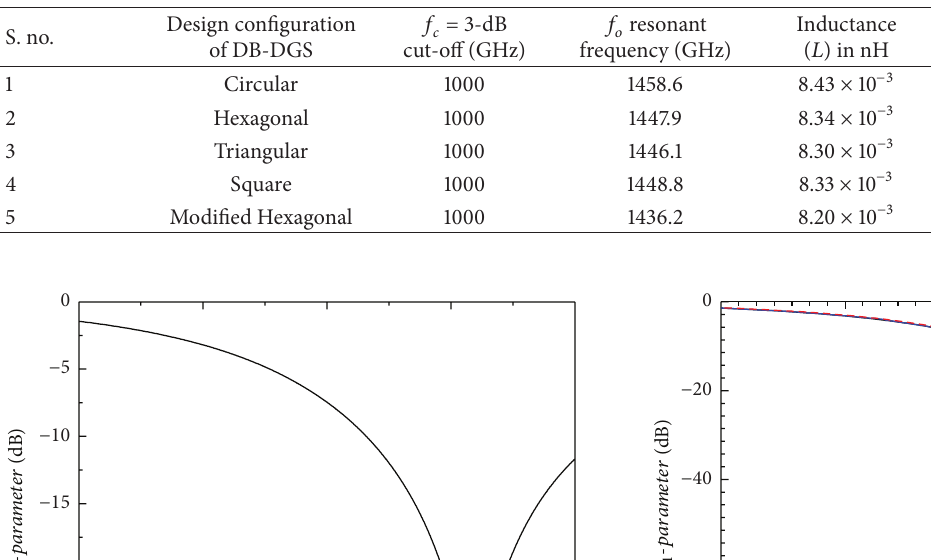
Table 2: Dimensions of various design configurations.